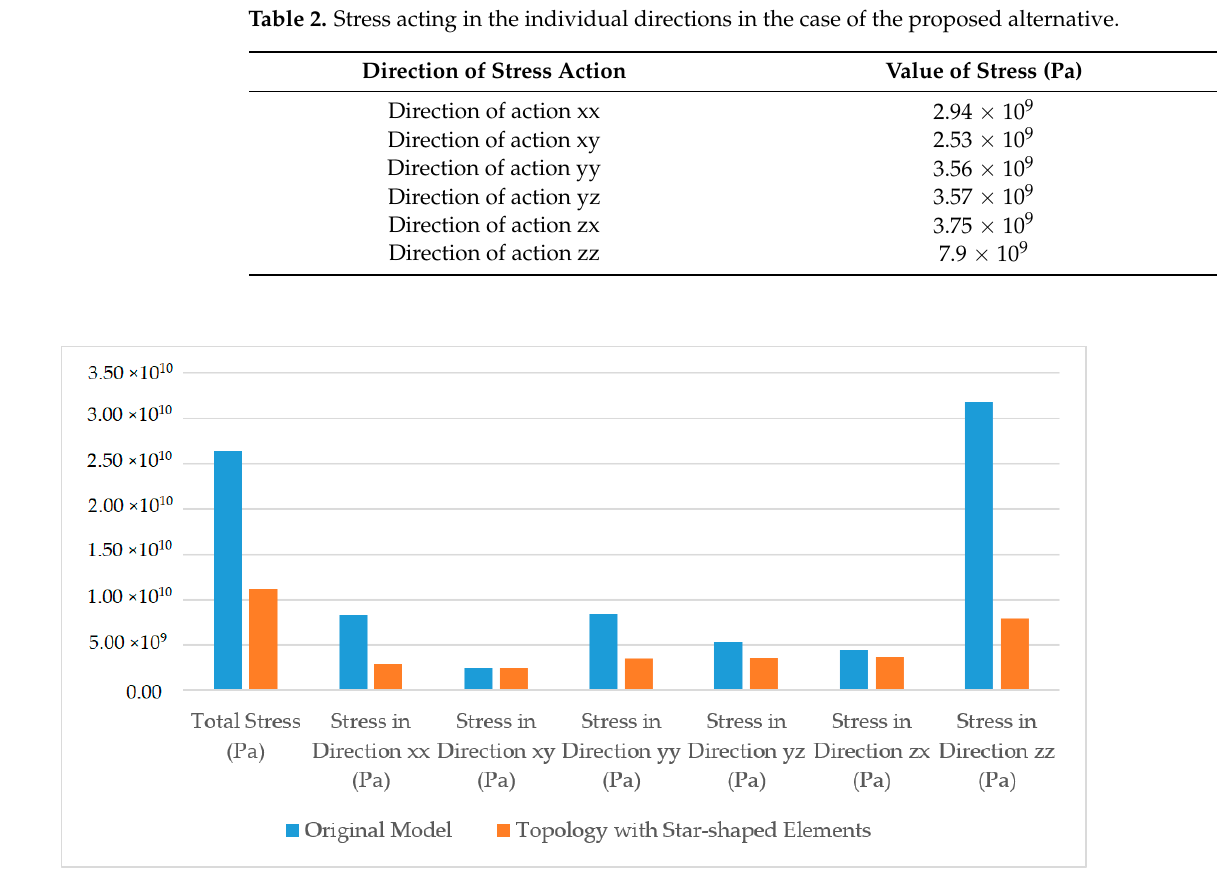
Figure 10. Comparison of overall and partial stress of the original model and the alternative solution with topology with star-shaped elements. Table 2. Stress acting in the individual directions in the case of the proposed alternative .